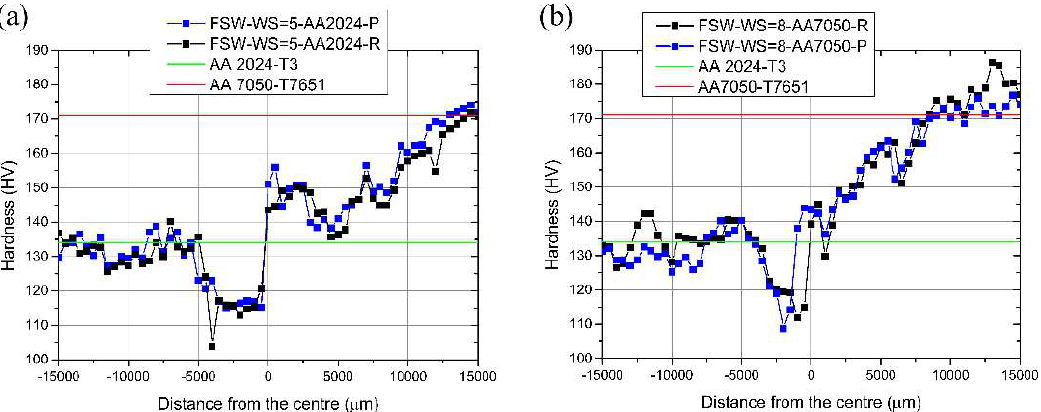
Figure 16. Microhardness for different material orientations: ( a ) WS = 5 mm/s, AA2024AS and ( b ) WS = 8 mm/s, AA7050AS.